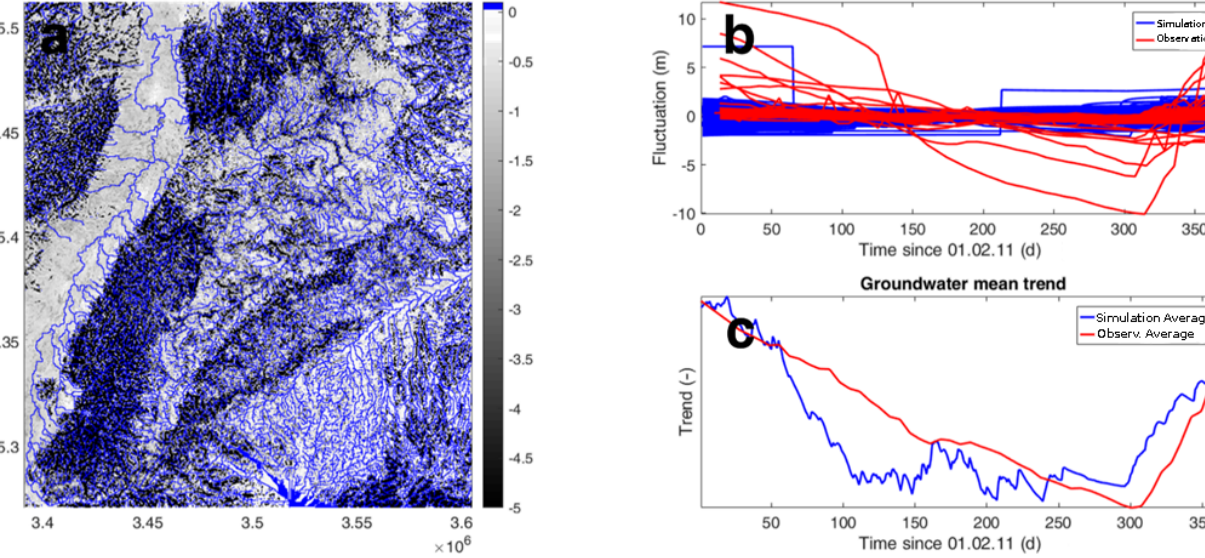
Figure 13. (a) Mean groundwater table depth of the entire domain for the year ranging from 1 February 2011 to 1 February 2012, (b) ground- water fluctuations around a zero mean, and (c) the total mean of all model cells and all real data points superimposed on top of each other to show the annual average trend. Please note that for readability of the figure, panel (a) is limited to a maximum depth of − 5m, while the underlying data ranged down to −